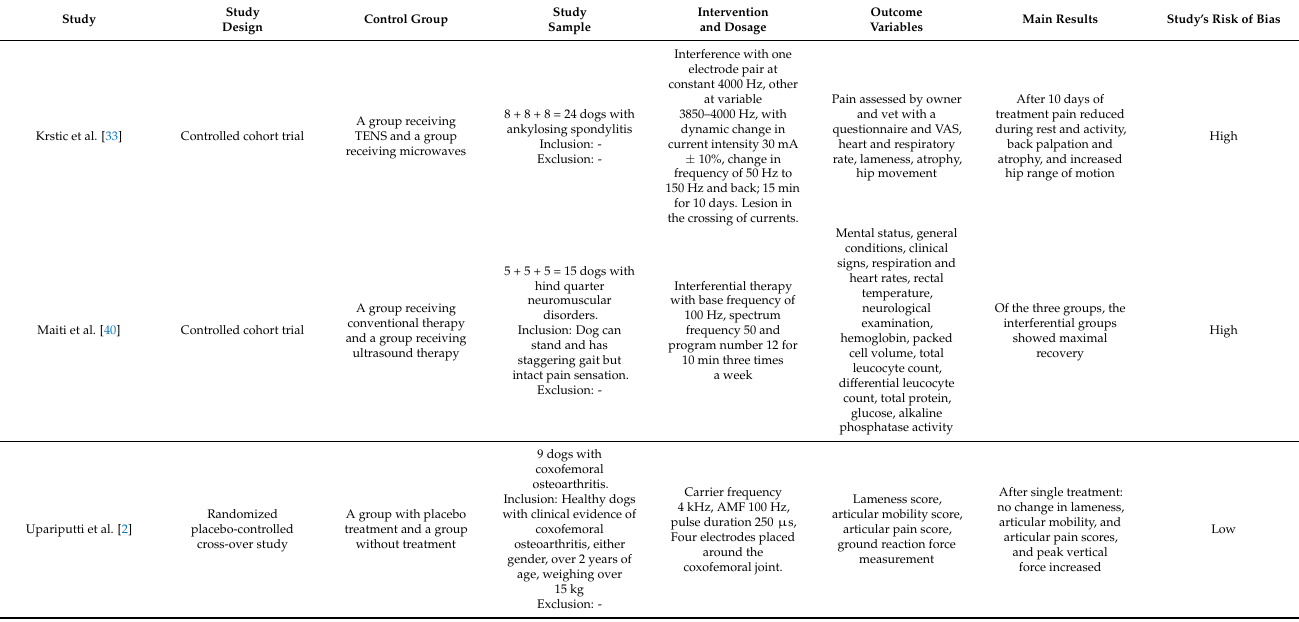
Table 6. Review of articles regarding interference